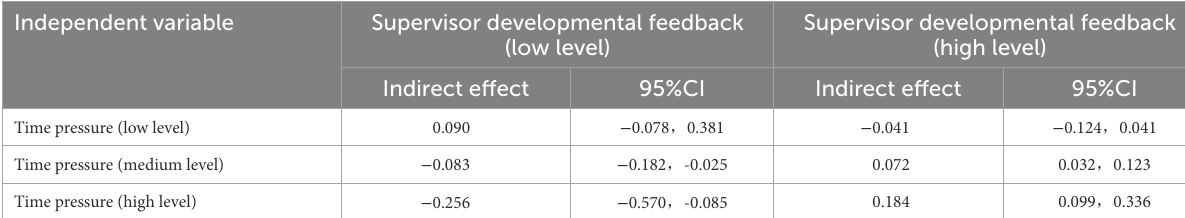
TABLE 7 Moderating effect of supervisor developmental feedback on the mediating effect of learning behavior (Study